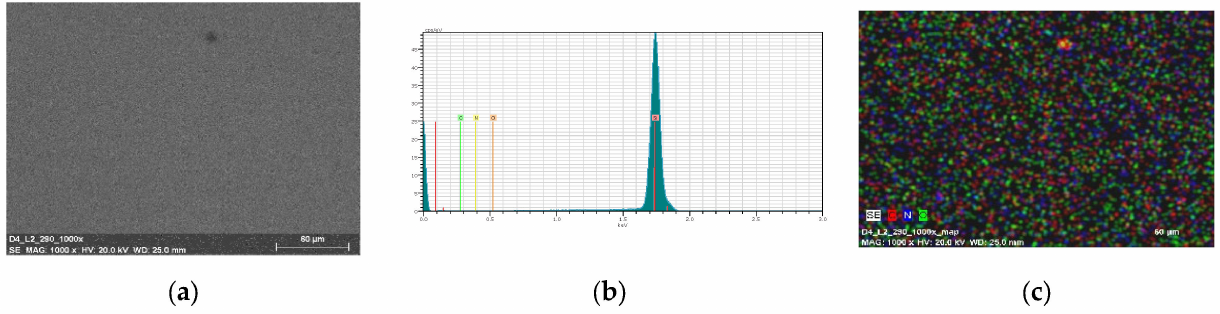
Figure 13. SEM of L2 /Si spin coating ( a ) L2 /Si, 2500 rpm 10s × 15 ( b ) EDS and ( c ) mapping of L2 /Si, 2500 rpm 10s × 15, scan size 1 µ